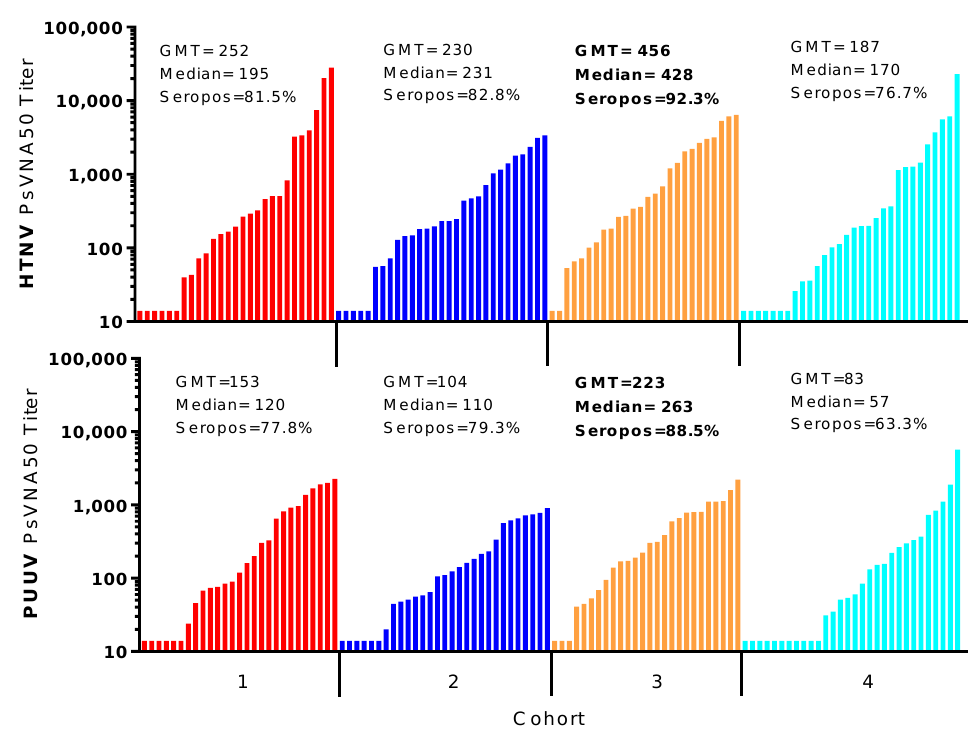
Figure 6. Peak PsVNA geometric mean titers (Day 196). Cohort geometric mean titers peaked on day 196. Cohorts are the same as defined in Figure 1A. Individual PsVNA50 titers were sorted lowest to highest and plotted for HTNV (top panel) and PUUV (bottom panel). GMT, median and % seropositive are plotted. Highest values are highlighted in bold text.